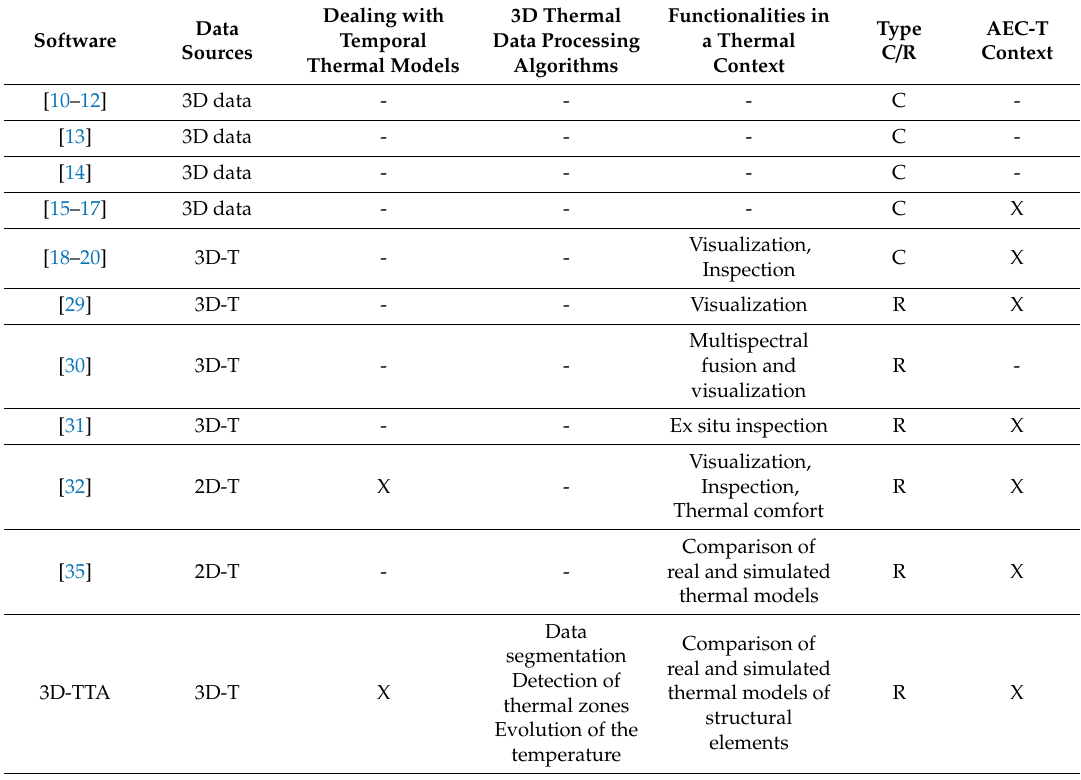
Table 1. Software technologies for 3D point clouds and 3D thermal data. (Abbreviations. 3D-T = 3D thermal data, 2D-T = 2D thermal data, C = Commercial, R =